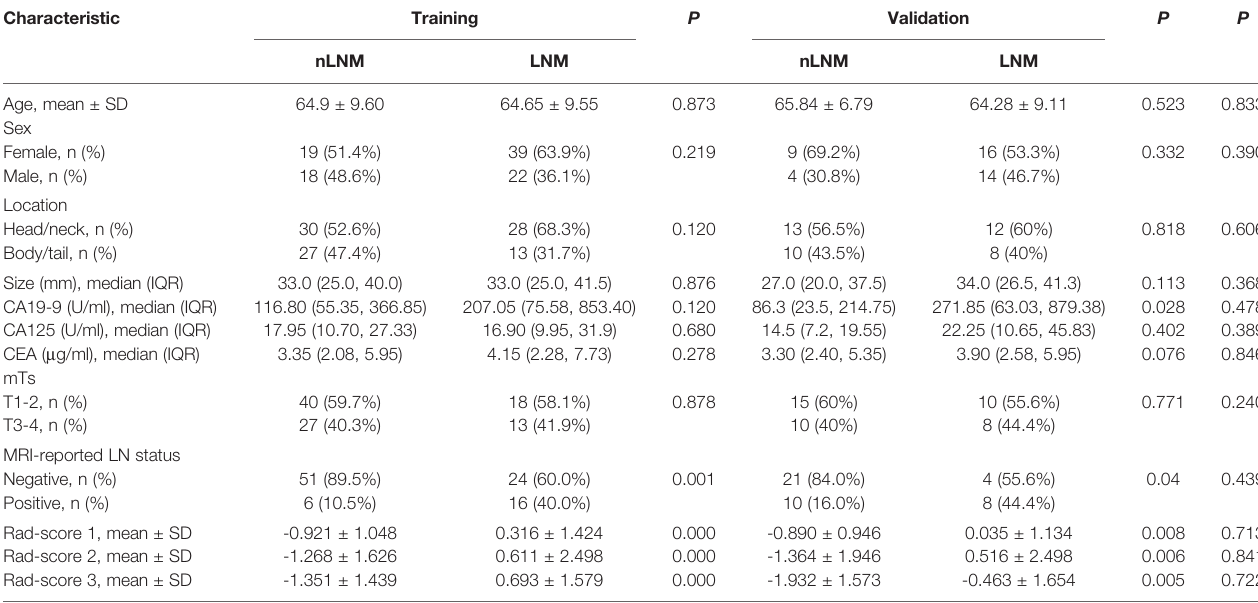
TABLE 1 | Patients ’ clinical characteristics and rad-scores in the training and validation cohorts.